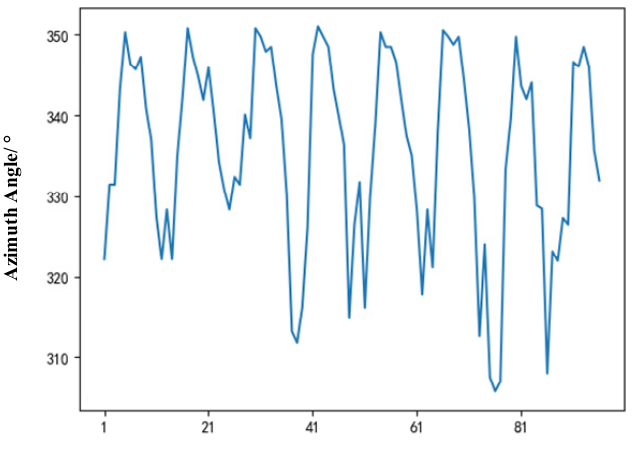
Figure 6. Offset azimuth trend.